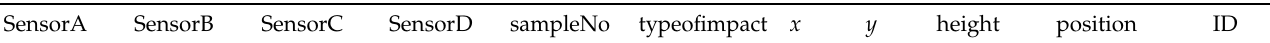
Table 3. Dataset format.